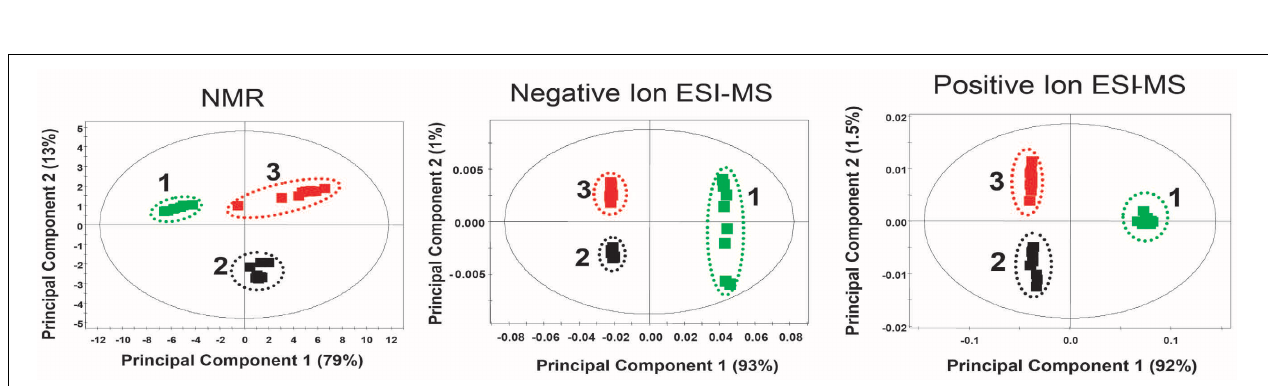
FIGURE 6 | Metabolite fingerprinting of bran extracts using NMR and DI-ESI-MS datasets. Extracts from 5 day old T. hamatum bran inoculum were analysed by 1 H-NMR and direct infusion electrospray ionization mass spectrometry. Principal components analysis (PCA) of full unfiltered data at 95% confidence intervals was used to evaluate differences in chemistry